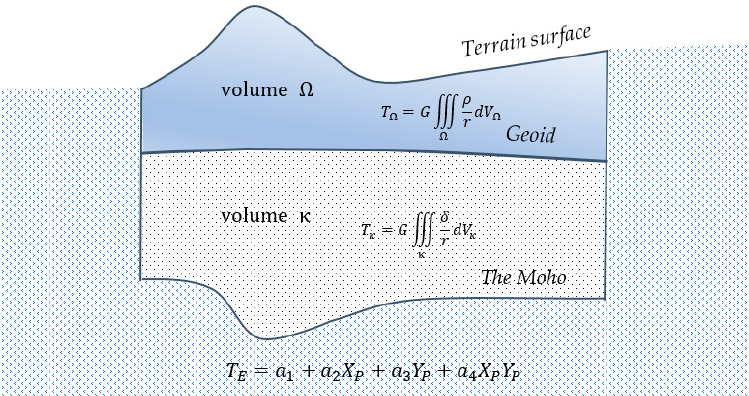
Figure 1. Components defining the disturbing potential model used in the GGI method.